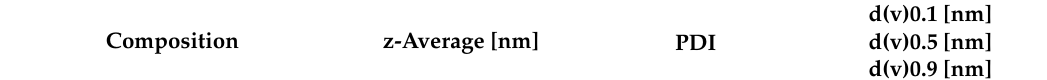
Table 1. Overview of the formulations used in the